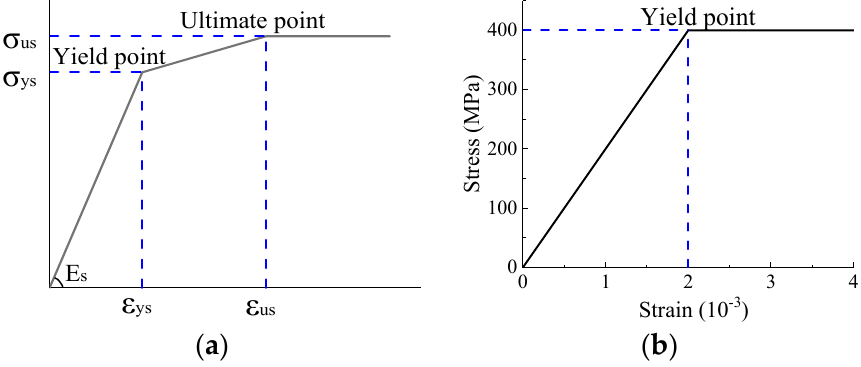
Figure 16. Stress–strain model for steels. ( a ) Steel plate; ( b ) reinforcing bar.